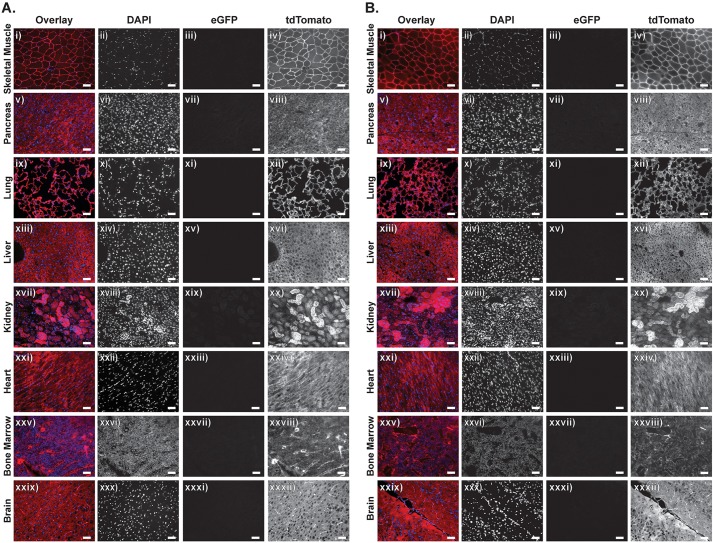
Characterization of Col1a1FRT-STOP-FRT-Cre-ER-T2 mice. (A) Immunofluorescence of tissues from 6-month-old Col1a1FRT-STOP-FRT-Cre-ER-T2; Rosa26mTmG/+ mice (n=2) without tamoxifen treatment show widespread tdTomato expression and no eGFP expression. (B) Immunofluorescence of tissues collected 30 days after one dose of intraperitoneal tamoxifen in 6-month-old mice (n=2) continue to show widespread tdTomato expression and no eGFP expression, indicating that the STOP cassette prevents expression of Cre-ERT2 in the absence of FlpO-mediated recombination and excision of the STOP cassette. Scale bars: 50 µm.